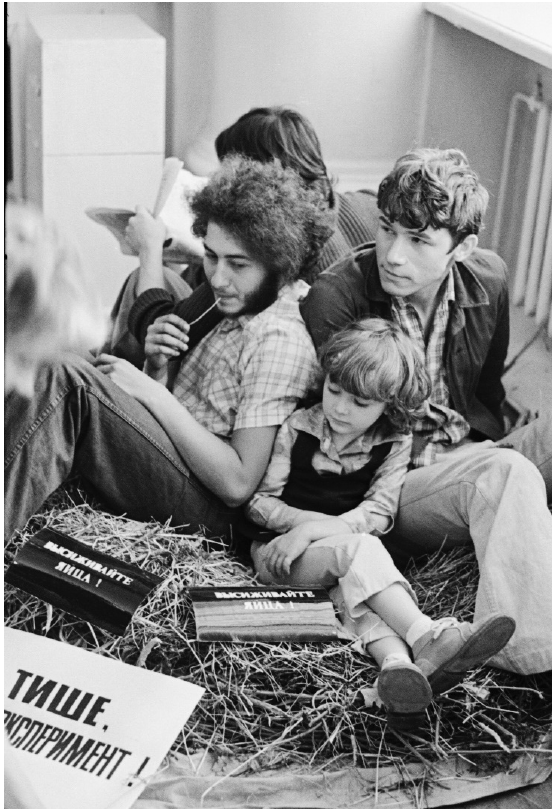
Figure 1. The Nest. Hatching a Spirit . 1975. Installation view. VDNKh exhibit, Moscow. Image courtesy of Victor Skersis. Photograph by Igor